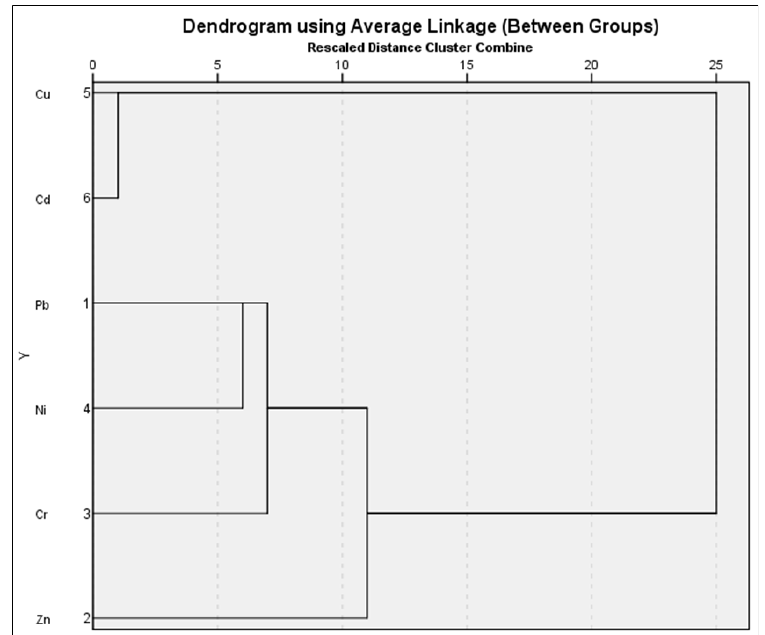
Figure 4. Dendrogram obtained by hierarchical cluster analysis of trace elements in soil samples of the study area.